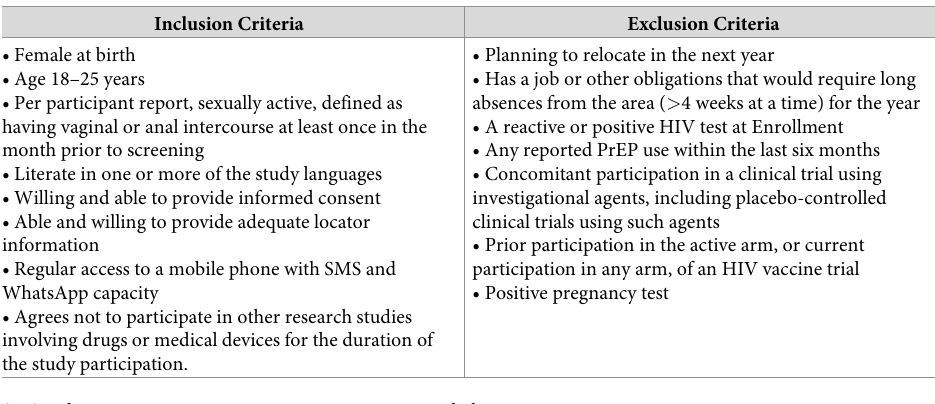
Table 1. Study inclusion and exclusion